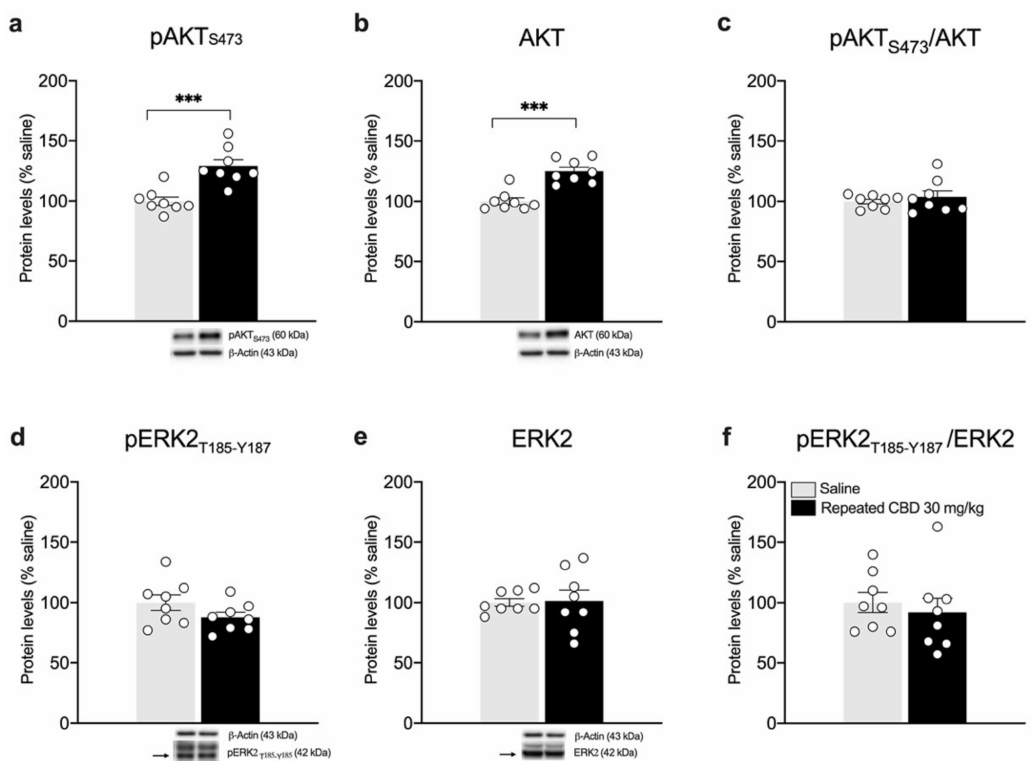
Figure 10. Effects of repeated CBD exposure on BDNF-downstream signaling in the striatum. Rats were treated with repeated injections of 30 mg/kg for seven days and killed twenty-four hours after the last treatment. Protein levels of phospho(p)-AktS473 ( a ), Akt ( b ), pAkt/Akt ( c ), pERK2T185-Y187 ( d ), ERK2 ( e ), and pERK2/ERK2 ( f ) measured in the homogenate of the striatum are expressed as percentages of saline-treated rats. Below the graphs, representative immunoblots are shown for pAktS473 (60 kDa), Akt (60 kDa), pERK2T185-Y187 (42 kDa), ERK2 (42 kDa), and β -Actin (43 kDa) proteins. Bar graphs represent the mean ± SEM from eight independent determinations for each experimental group. Unpaired Student’s t -test. *** p < 0.001 vs. saline-treated rats. Saline n = 8, CBD 30 mg/kg n =